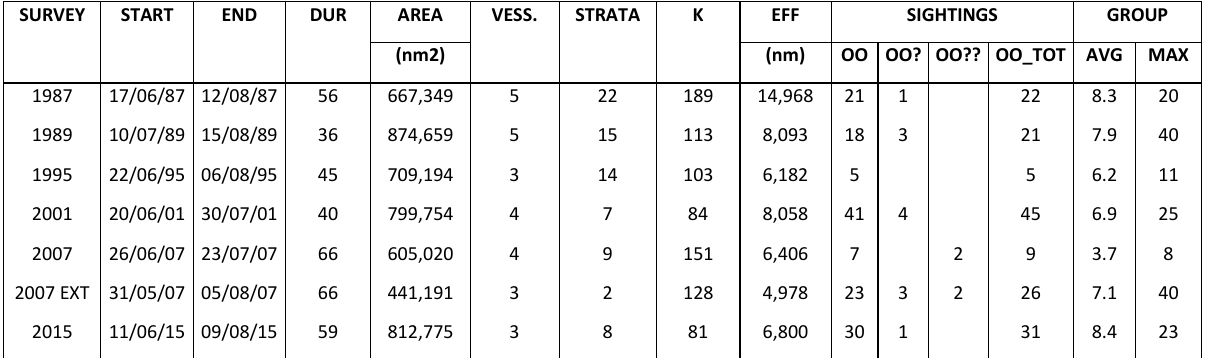
Table 1. Effort and sightings of killer whales on NASS ship surveys, 1987-2015, in sea states of Beaufort 4 or less. The data for the 2007 extension survey is provided separately. DUR - duration, days; VESS. - number of vessels; K - number of transects; EFF - survey effort; OO - number of killer whale sightings. Number of ? indicates identification uncertainty. Group - group